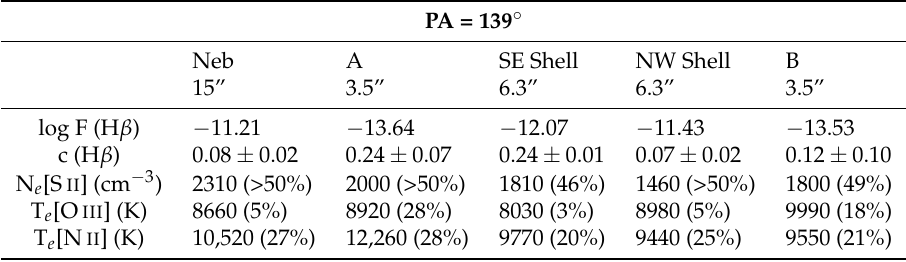
Table 2. Results for position angle 139 ◦ . Percentage errors are given within